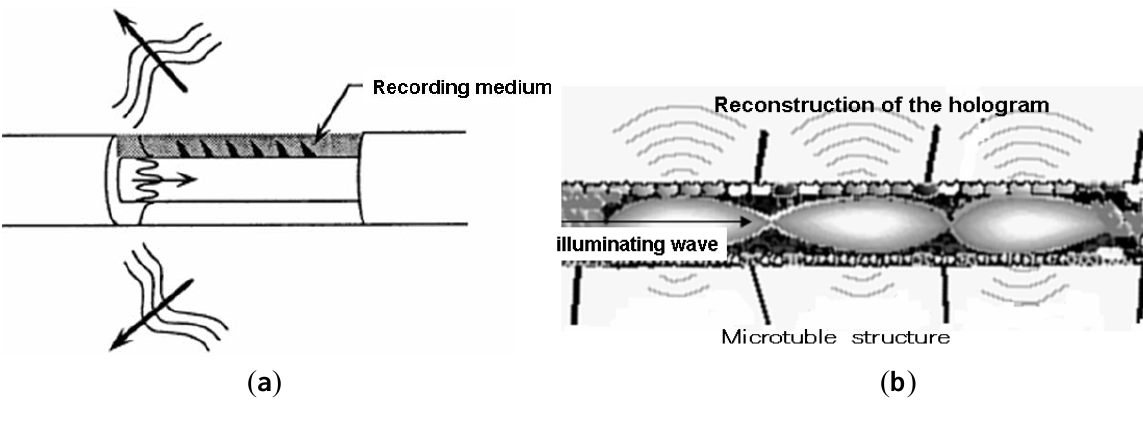
Figure 3. (a) Reconstruction of wave field by the guided readout wave; (b) Microtubule structure and the reconstruction of the hologram